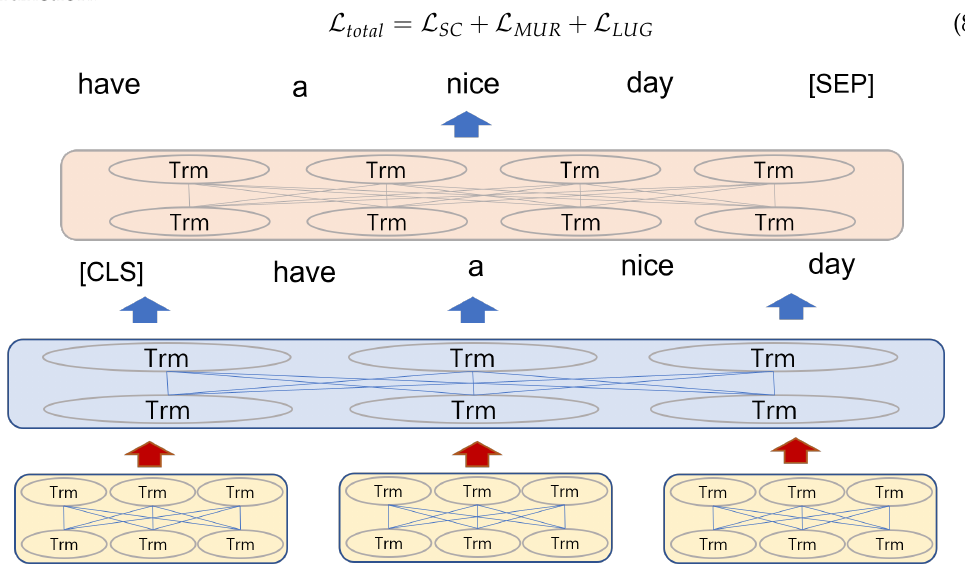
Figure 8. Overview of Last Utterance Generation. The hierarchical Transformer encoder–decoder ar- chitecture. As shown in this figure, the decoder takes the conversation-level encoded representations of contexts as an input and generates the response.